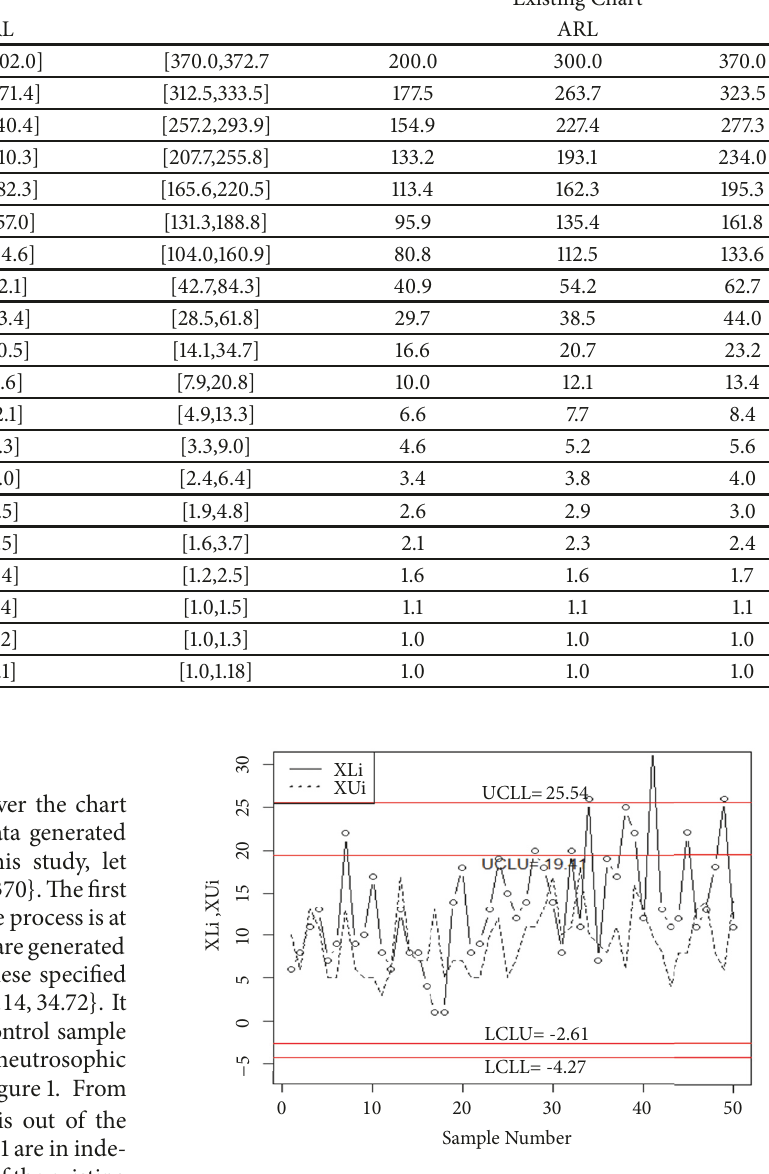
Table 4: Comparison of NARLs when V 𝑁 𝜖[0.4,0.6] and 𝑢 0𝑁 𝜖[2.5,3.5] . Proposed Chart